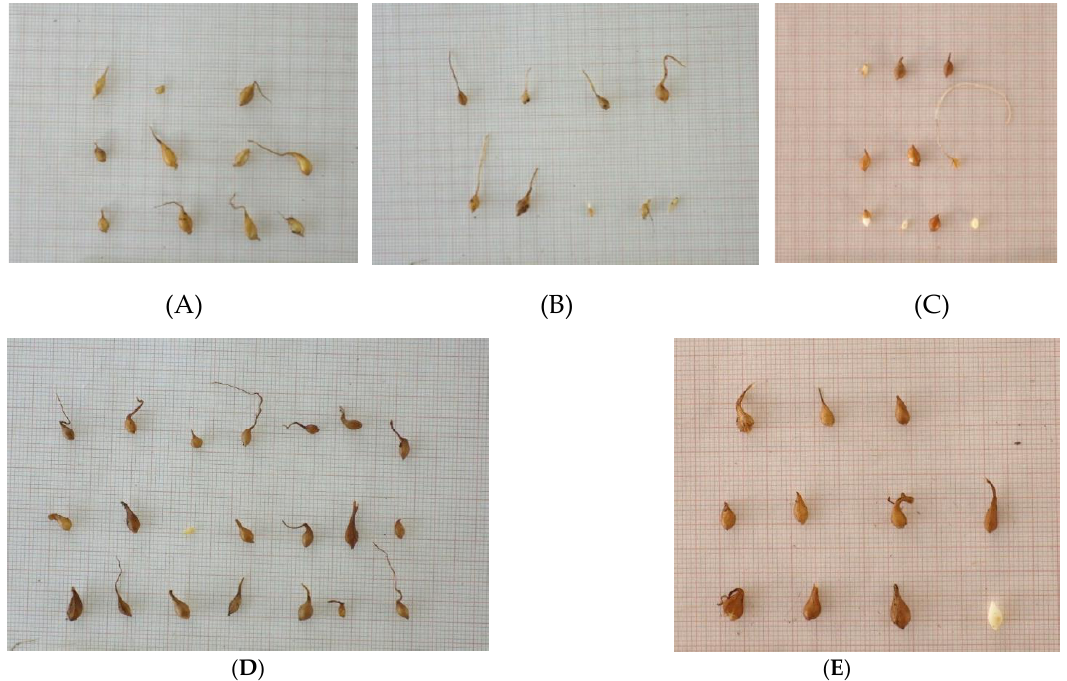
Figure 8. Bulblets produced from seedlings of Greek wild-growing tulips ( Tulipa spp.) at the end of their first growing season: ( A ) T. australis ; ( B ) T. bakeri ; ( C ) T. clusiana ; ( D ) T. goulimyi ; ( E ) T. undulatifolia.